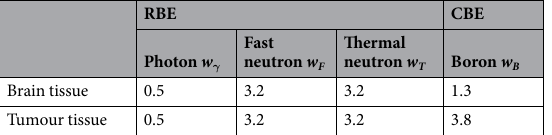
Table 5. Relative biological effectiveness factors and CBE factor (only for boron dose) for four principal dose components 11